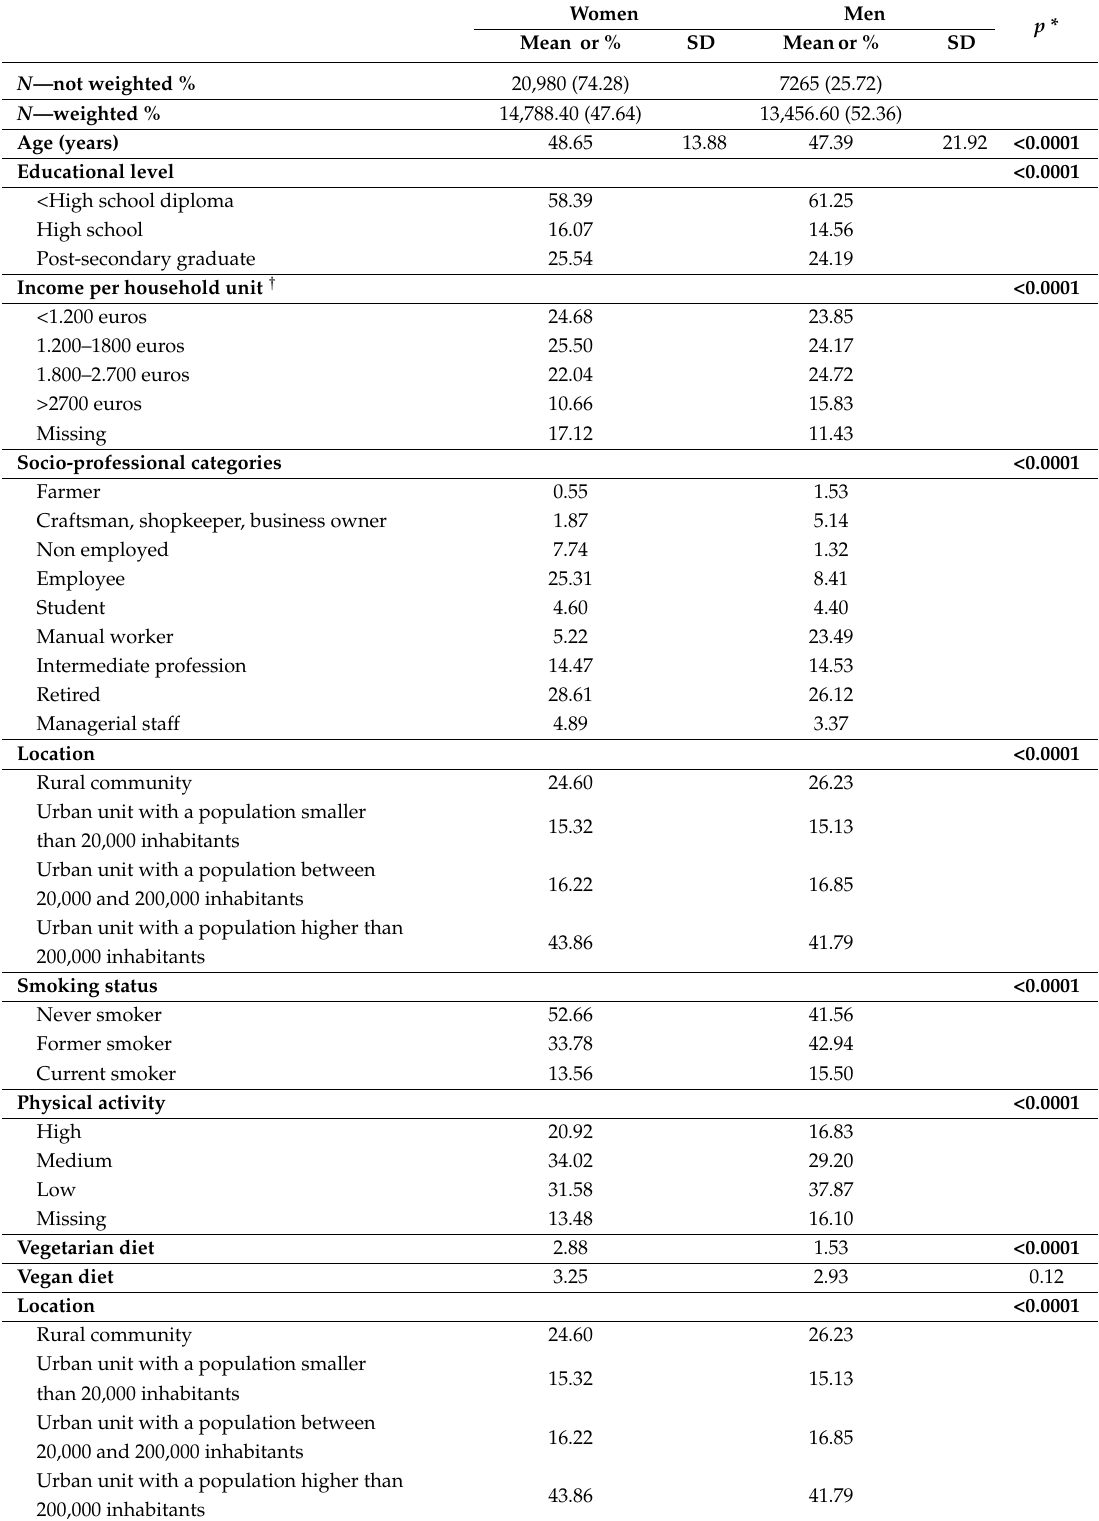
Table 1. Sociodemographic and lifestyle characteristics of the weighted sample, NutriNet-Santé Study, N =